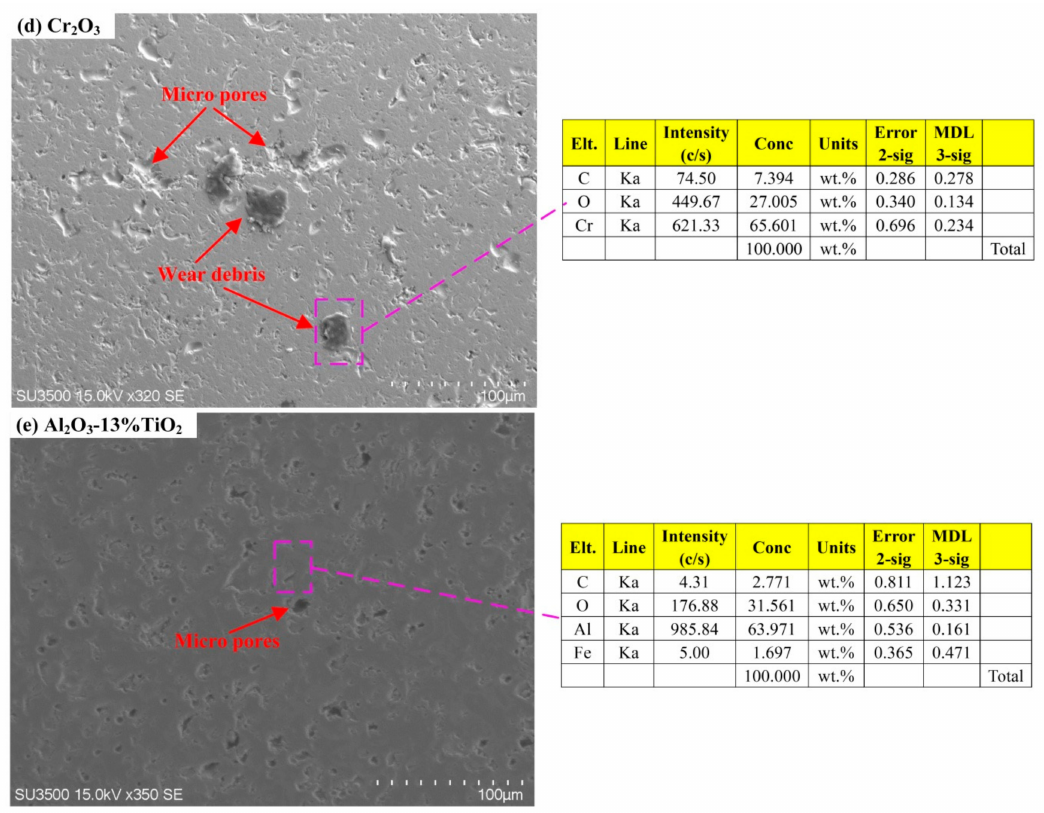
Figure 6. Worn surfaces morphology and the corresponding EDS results of di ff erent cermet coatings (100 N, 300 r / min): ( a ) 17-4PH; ( b ) Cr 3 C 2 -NiCr; ( c ) WC-10Co-4Cr; ( d ) Cr 2 O 3 and ( e ) Al 2 O 3 -13%TiO 2